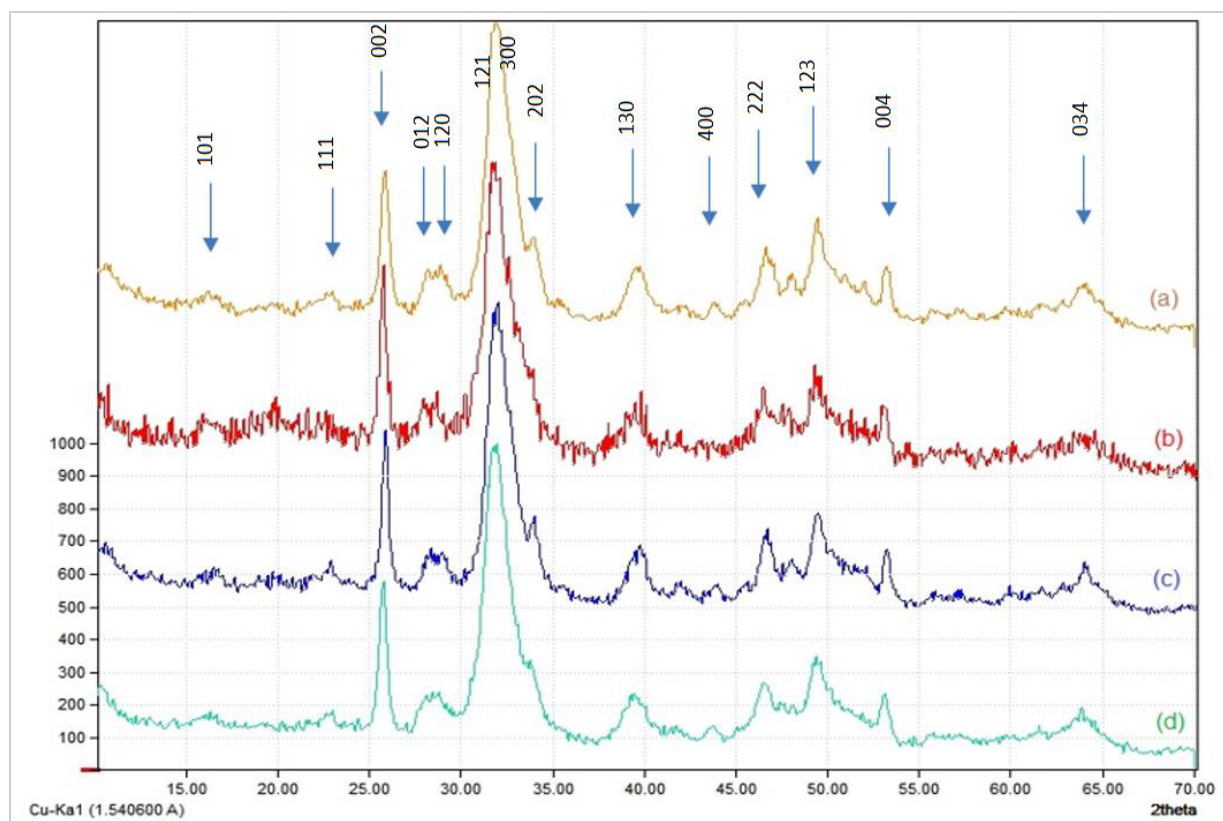
Figure 2. X-ray diffraction patterns of HAp/CTs composites: ( a ): 30/70; ( b ): 25/75; ( c ): 20/80 et; ( d ): 15/85.